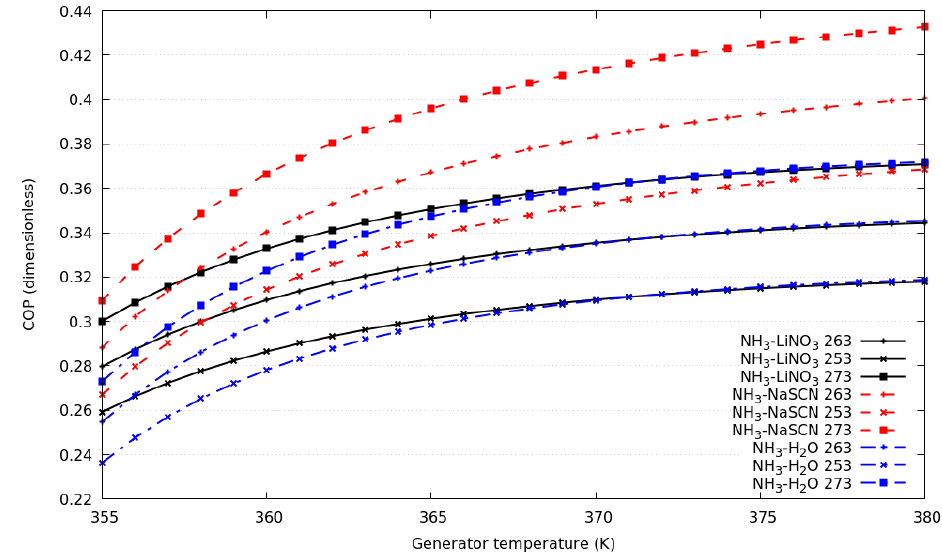
Figure 2. Coefficient of performance against generator temperature for evaporation temperature in the absorption cycle of 253 K, 263 K and 273 K.